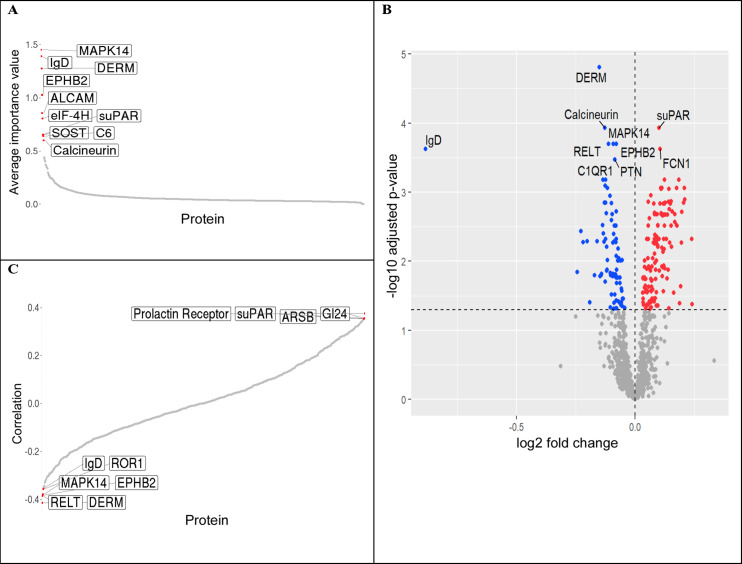
Top-10 predictive proteins identified by three different methods.(A) Random Forest-based method. (B) T-test based method. A volcano plot of group comparison revealed a total of 86 proteins were downregulated in the ASD boys and 52 proteins were upregulated. All of these proteins had a false discovery rate <0.05. (C) Correlation-based method.